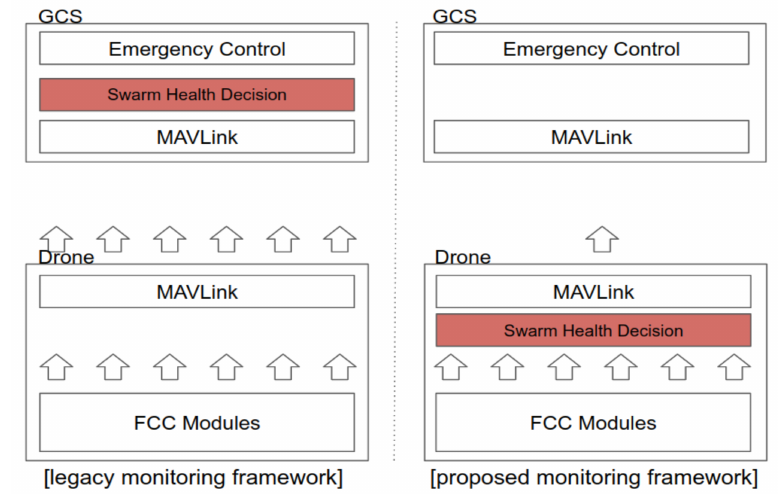
Figure 6. Comparison of monitoring methods.